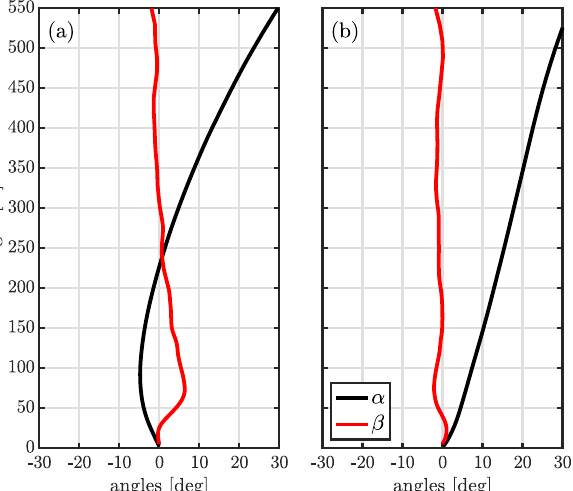
Figure 8. Vertical profiles of turning angles computed from the idealized neutral WRF-LES over ( a ) water and ( b )